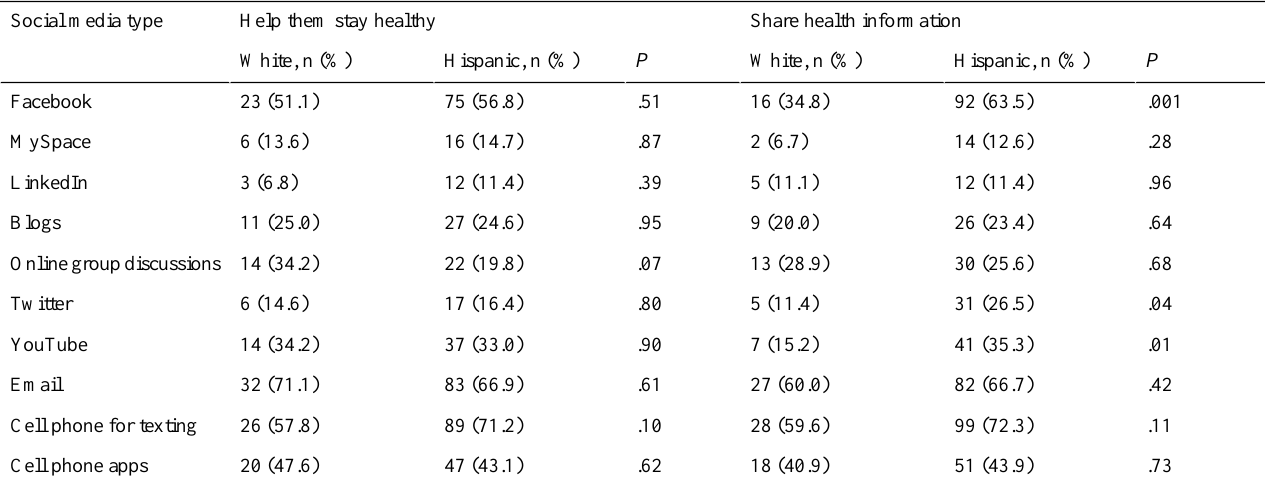
Table 3. Number and percentage of whites and Hispanic patients who prefer that their provider use various social media to help them stay healthy and share health information